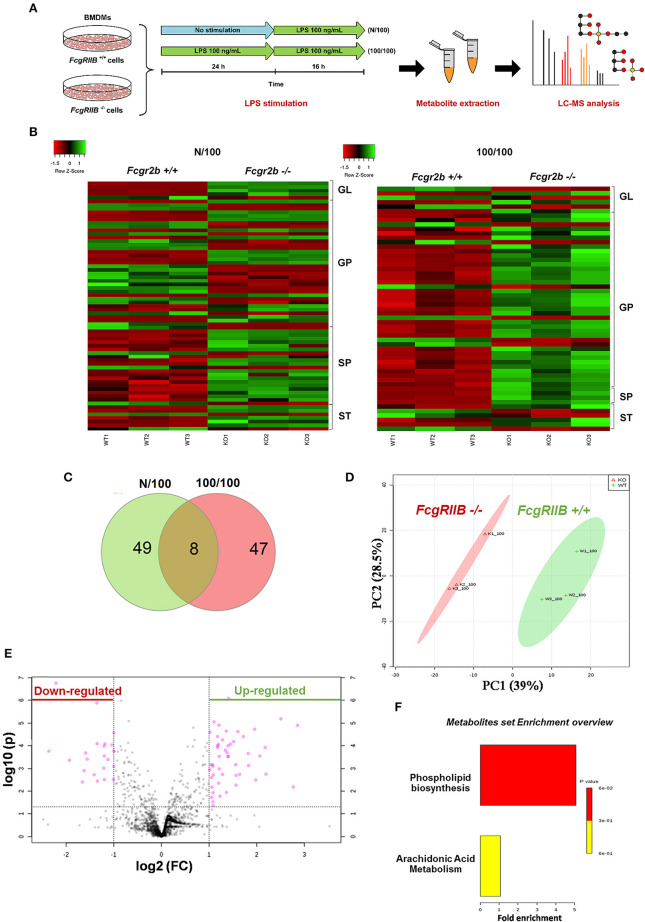
Schematic of experimental design for mass-spectrometry (LC-MS) based lipidomic analysis from bone marrow derived macrophages (BMDM) of FcgRIIB–/– and wild-type (FcgRIIB+/+) with single (N/100) and sequential (100/100) LPS stimulation (A) is demonstrated. Lipidomic analysis presented by hierarchical clustering heat-map profiling groups of lipid derivatives identified as glycerolipid (GL), glycerophospholipid (GP), sphingosine (SP), and sterol (ST) between wild-type (FcgRIIB+/+) and FcgRIIB–/– macrophages after LPS stimulation with the green and red color indicated up and downregulated lipid derivatives, respectively, (B) are shown. Venn diagram indicating the number of lipid derivatives in FcgRIIB–/– macrophages with N/100 or 100/100 LPS stimulation (C), principal cluster analysis (PCA) in principle component 1 (PC1) identifying variance between individual groups from wild-type (WT1-3) vs. FcgRIIB–/– (K1-3) and in principle component 2 (PC2) indicating variance between replicate experiments (D), Volcano plot of lipid derivatives quantification from sequential LPS stimulation (100/100) in wild-type vs. FcgRIIB–/– cells summarizing up- and downregulated lipid derivatives based on the adjusted log2 fold change (E), and enrichment pathway analysis (F) are also indicated.